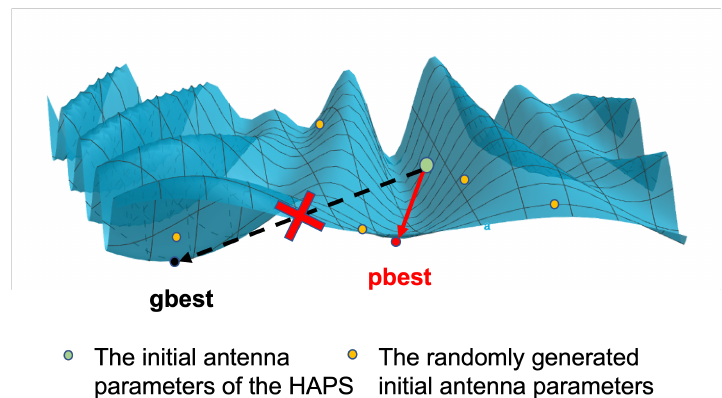
Figure 6. An example of how to find the optimal